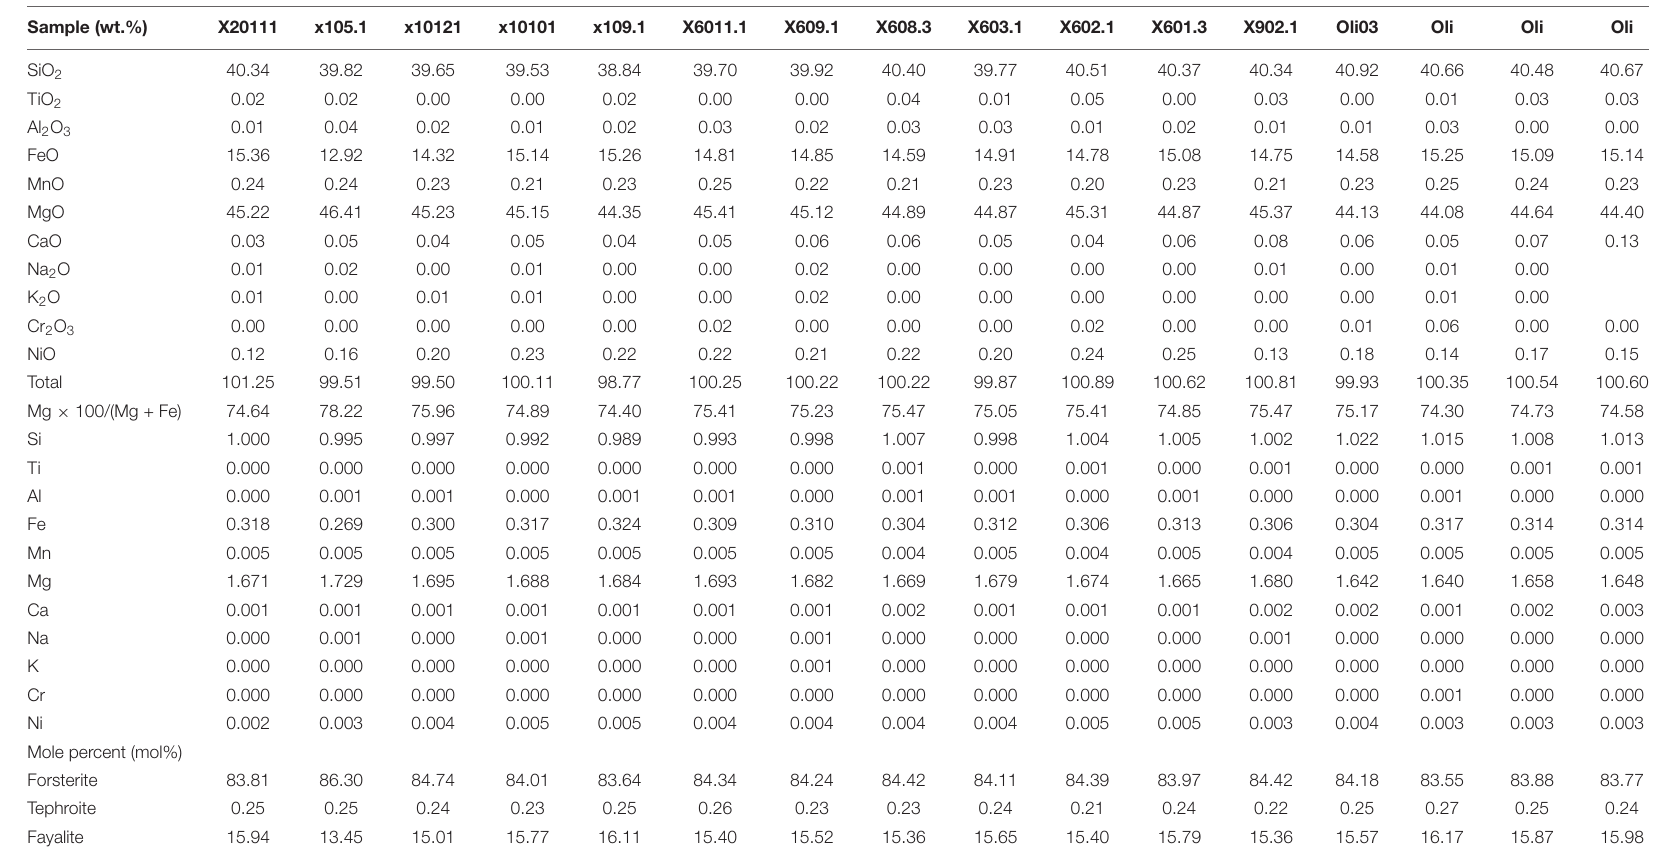
TABLE 3 | The composition of microprobe analysis of olivine in olivine gabbro from the Xiwanggou deposit. Sample